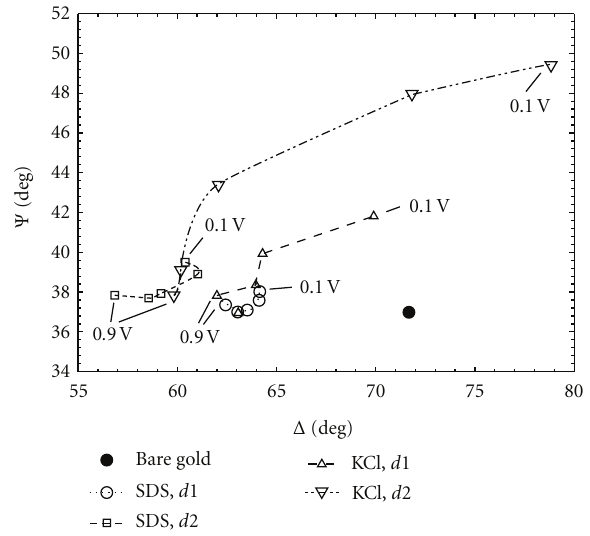
Figure 5: Evolution of the experimental parameters Δ and Ψ as a function of the applied potential for Ppy film grown in SDS, after applying both four or five successive cycles and using Ea = 1.2 V, τ = 20s. ( (cid:5) ) in SDS and ( (cid:2) ) after immersion in KCl. τ = 5 s. This e ff ect probably stems from the anodic oxidation of the Py dissolved in the SDS micelles, which can solvate part of the reaction intermediates (free radicals) as well as the resulting Ppy oligomers. DS has a charged, polar end and a hydrophobic end. The charged end facing out